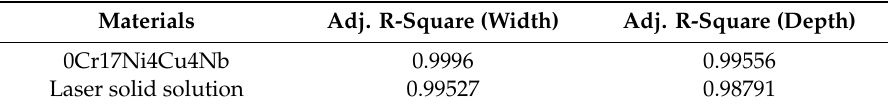
Table 2. The accuracy of these fitted curves.